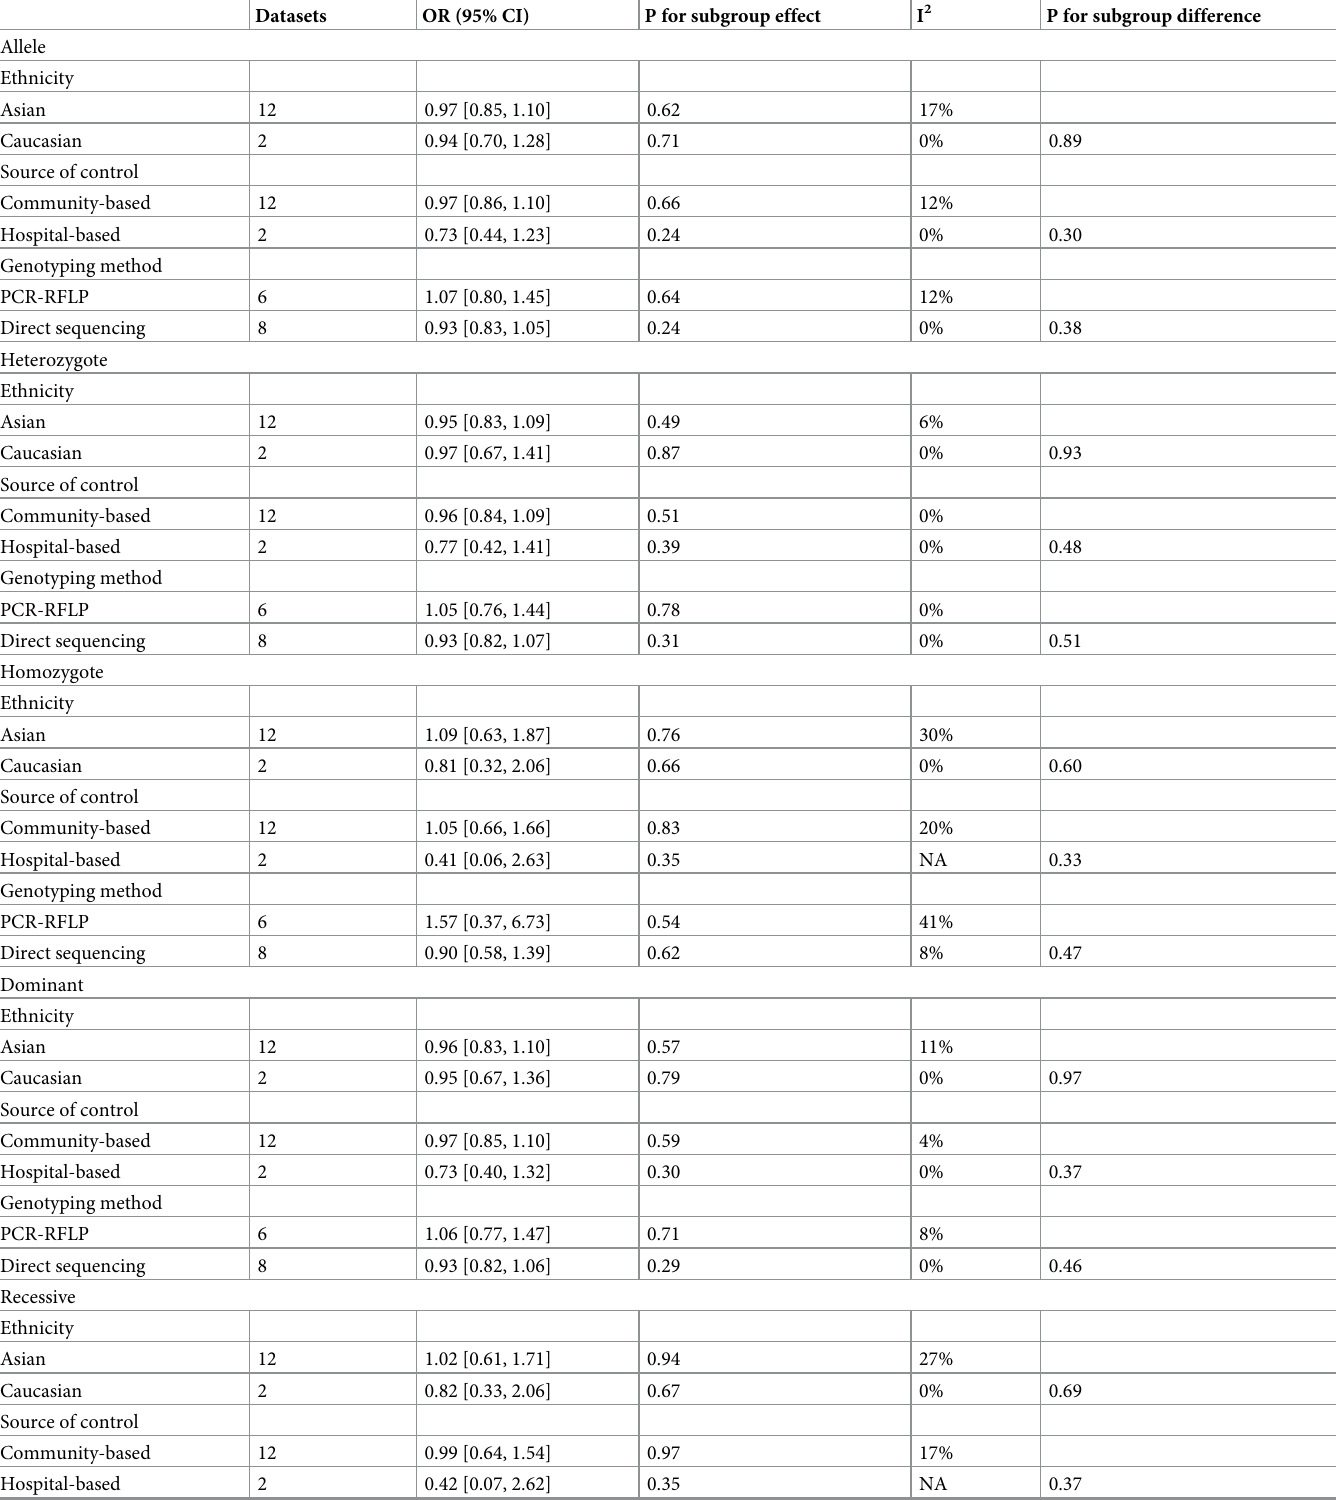
Table 3. Subgroup analysis for the association between MTR A2756G and CHD